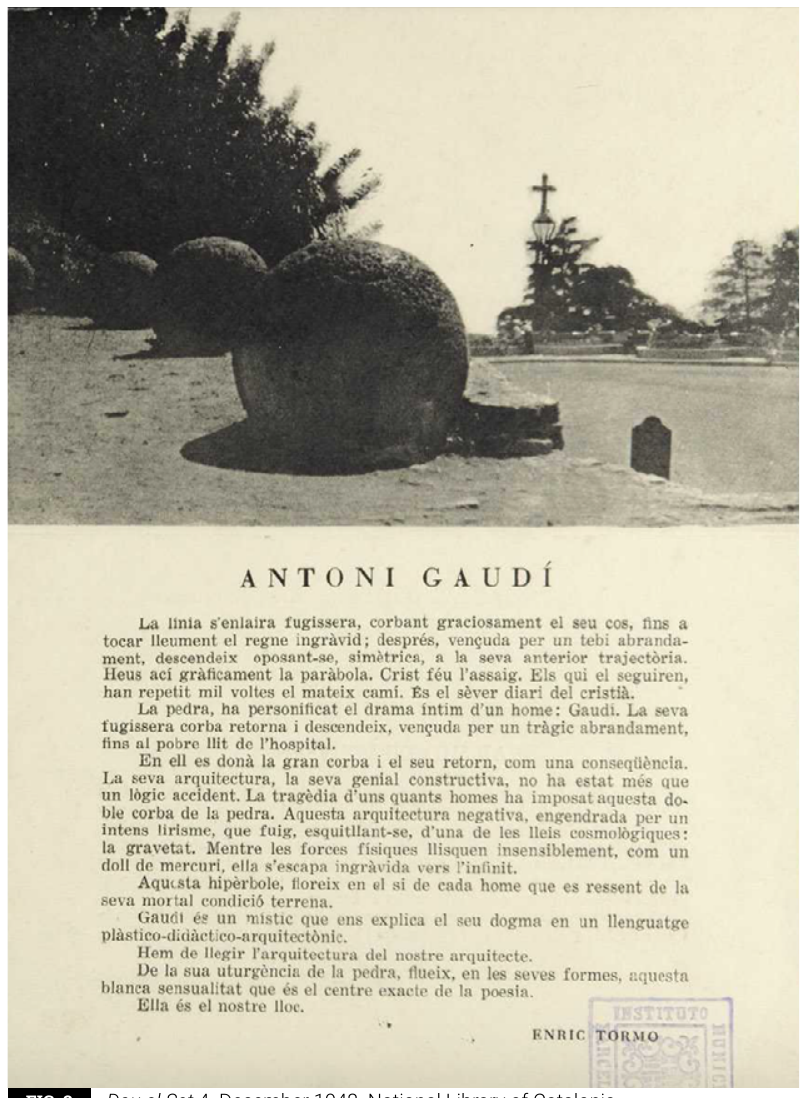
Dau al Set 4. December 1948. National Library of Catalonia FIG.